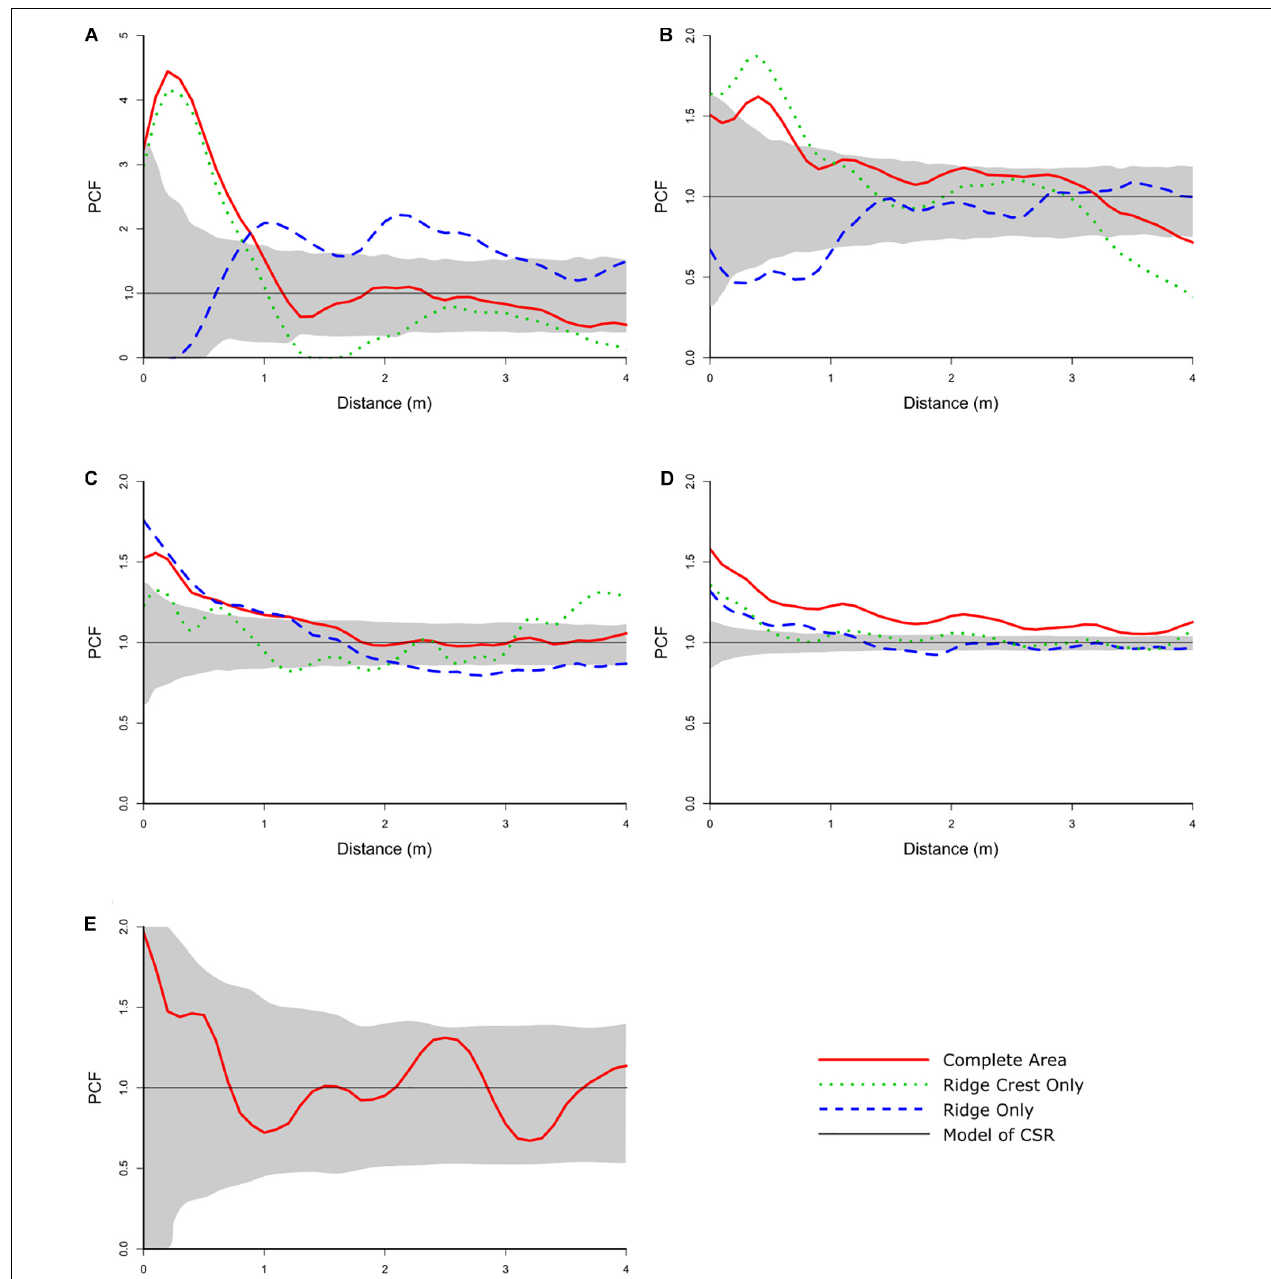
FIGURE 5 | Univariate PCF for the abundant taxa. (A) Narella macrocalyx , (B) Narella bowersi , (C) Advhena magnifica, (D) Aspidoscopulia, (E) Rhodaniridogorgia . The gray area is the simulation envelope for 999 Monte Carlo simulations of complete spatial randomness. The x -axis is the inter-point distance between organisms in meters. On the y -axis PCF = 1 indicates complete spatial randomness (CSR), < 1 indicates segregation, and > 1 indicates aggregation.